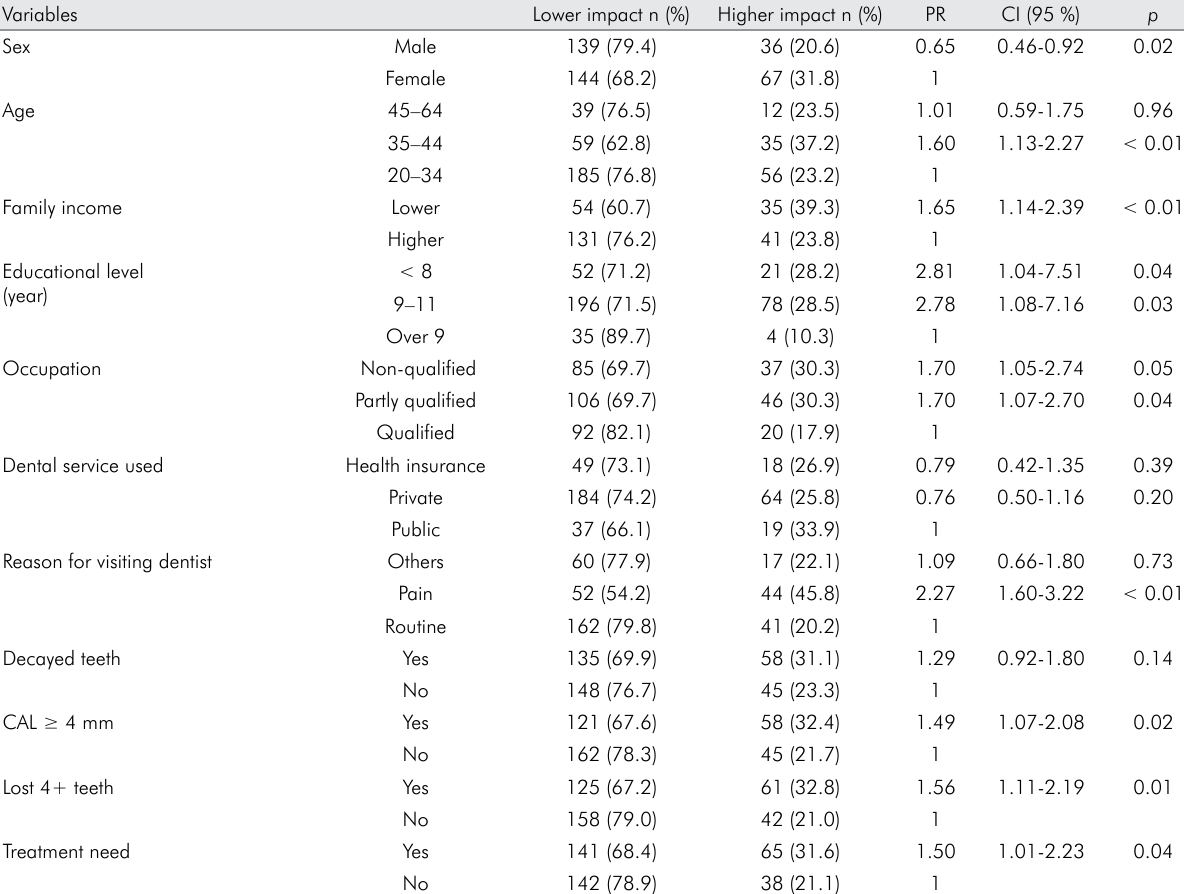
Table 3. Bivariate analysis of impacts on OHRQoL.